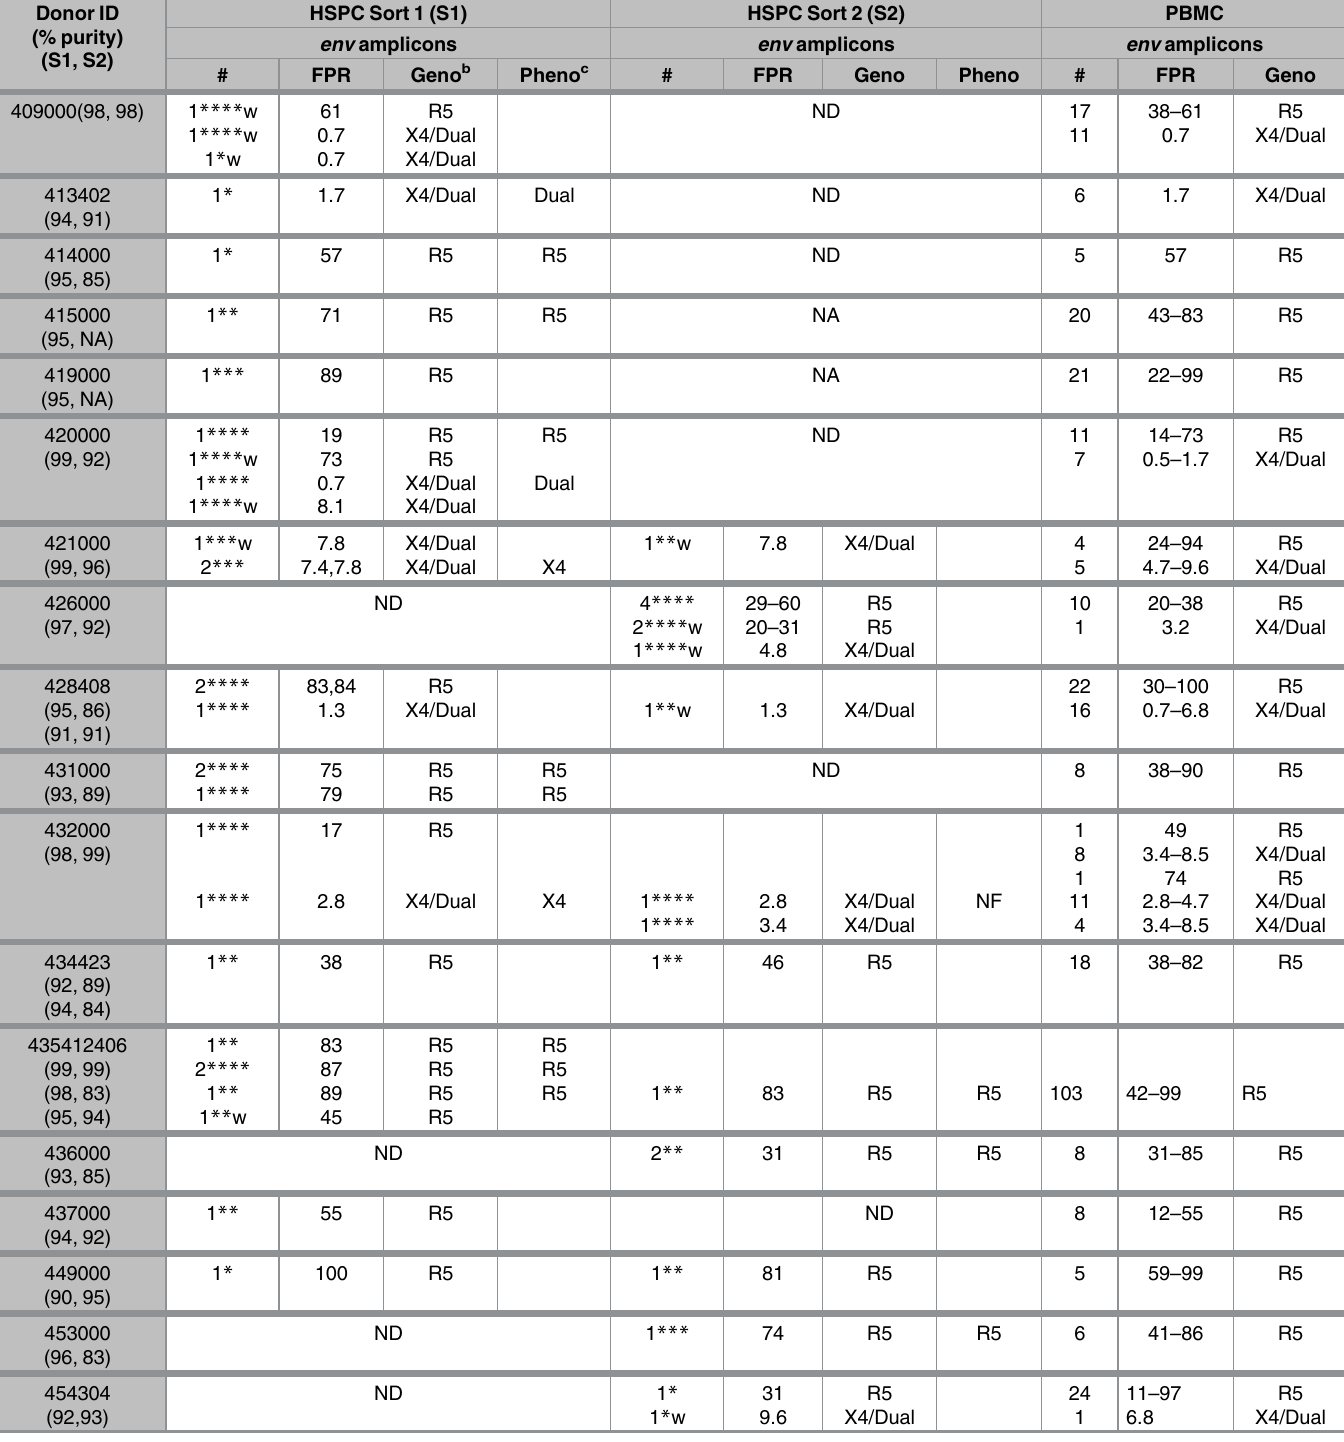
Table 3. Analysis of env amplicons isolated from HIV +